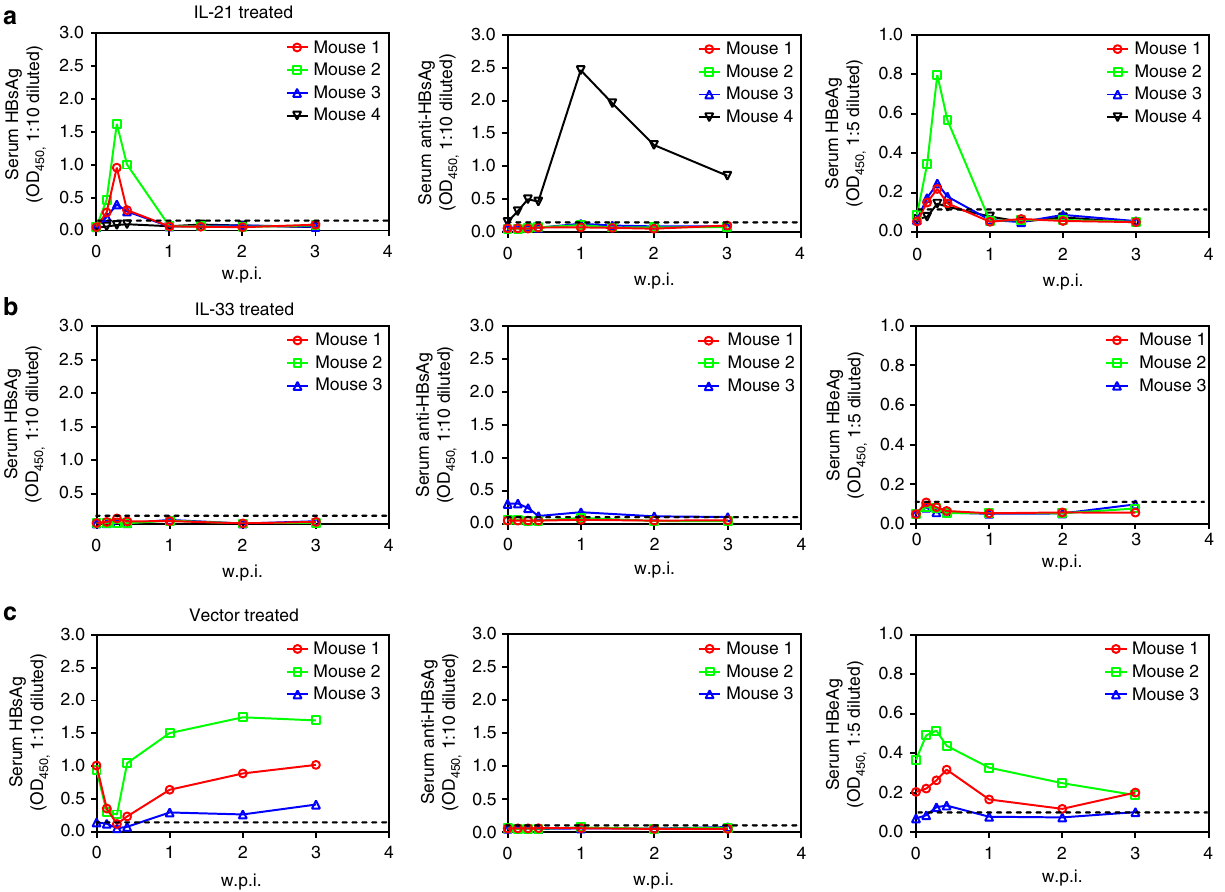
Fig. 7 IL-21-induced or IL-33-induced clearance of BPS persistence engenders protection from re-challenge. HDI mice harbouring BPS persistence were treated with injections of plasmids expressing IL-21 ( a ) or IL-33 ( b ) at 4 and 7 w.p.i. and those displaying at least 4 weeks of sustained HBsAg negativity (see Fig. 6) were re-challenged in the same way as initial BPS HDI. BPS HDI mice treated with vector control were used as control and re-challenged similarly ( c ). Sera were collected at indicated time points and levels of HBsAg (left), HBsAb (middle) and HBeAg (right) were analysed using ELISA. Dotted lines represent cut-off thresholds. w.p.i. weeks post injection of BPS re-challenge HBV genome into pUC18 (Takara, China) (Supplementary Fig. 1a). BPS/X null , BPS/P null and BPS/C null were created by prematurely terminating X, P and C ORFs (Supplementary Fig. 1b, d). BPS/ ε null was created by introducing inactivating mutations 21 in ε packaging signal (Supplementary Fig. 1c, d). Mutations were designed to change overlapping ORF(s) only synonymously. BPS/M plus was created by introducing V1M mutation into preS2 ORF, with concurrent R300H mutation in overlapping P ORF (Supplementary Fig. 1b, d). HBx of BPS and B6 were cloned downstream of CMV promoter and FLAG tag in pCMV-N-Flag vector (Beyotime, China) to create pBPSX and pB6X. X null mutation was introduced into pB6X to create pB6Xm. Luciferase-expressing pGL3 (Promega, China) was used as trans- fection control. HBV HDI plasmid harbouring AAV sequences (pAAV/HBV) was a gift from Professor Pei-Jer Chen, National Taiwan University 12 . Mouse IL-21 (MG50137-M-N) and IL-33 (MG50118-M-N) expression plasmids (Sino Biologi- cal, China) and rat monoclonal antibodies (anti-mIL-21: 16-9333; anti-mIL-33, 16- 7211) (eBioscience, China) were purchased. Transfection and analysis of HBV markers and virions . Culture and transfection of Huh-7 (TCHu182, Cell Bank of Chinese Academy of Sciences, China) and HepG2 (American Tissue Culture Collection, ATCC ® Number: HB-8065 ™ , Manassas, VA) cells were performed as previously described 22,29 . Secreted HBV antigens were measured by ELISA (KHB, China) at 48 h post-transfection. Intra- cellular proteins were analysed using harvested cells in Western blot and antibodies against HBsAg (1:3000, NB100-62652, Novus), FLAG (1:3000, F3165, Sigma) and actin (1:50,000, A3584, Sigma). Original uncropped Western blots are shown in Supplementary Fig. 34. Intracellular capsid-associated HBV DNA was extracted and analysed in Southern blot using digoxigenin-labelled probes as previously described 22,29 . Brie fl y, transfected cells were lysed in 50 mM Tris/HCl (pH 7.5) containing 1% NP-40 and 8% sucrose at 37 °C for 15min. DNase I (Sigma) and RNase A (Sigma) were then added to a fi nal concentration of 100 μ g/ml plus 10mM MgCl 2 to degrade free nucleic acids at 37°C for 1h. Lysates were cleared by NATURE COMMUNICATIONS | 8: